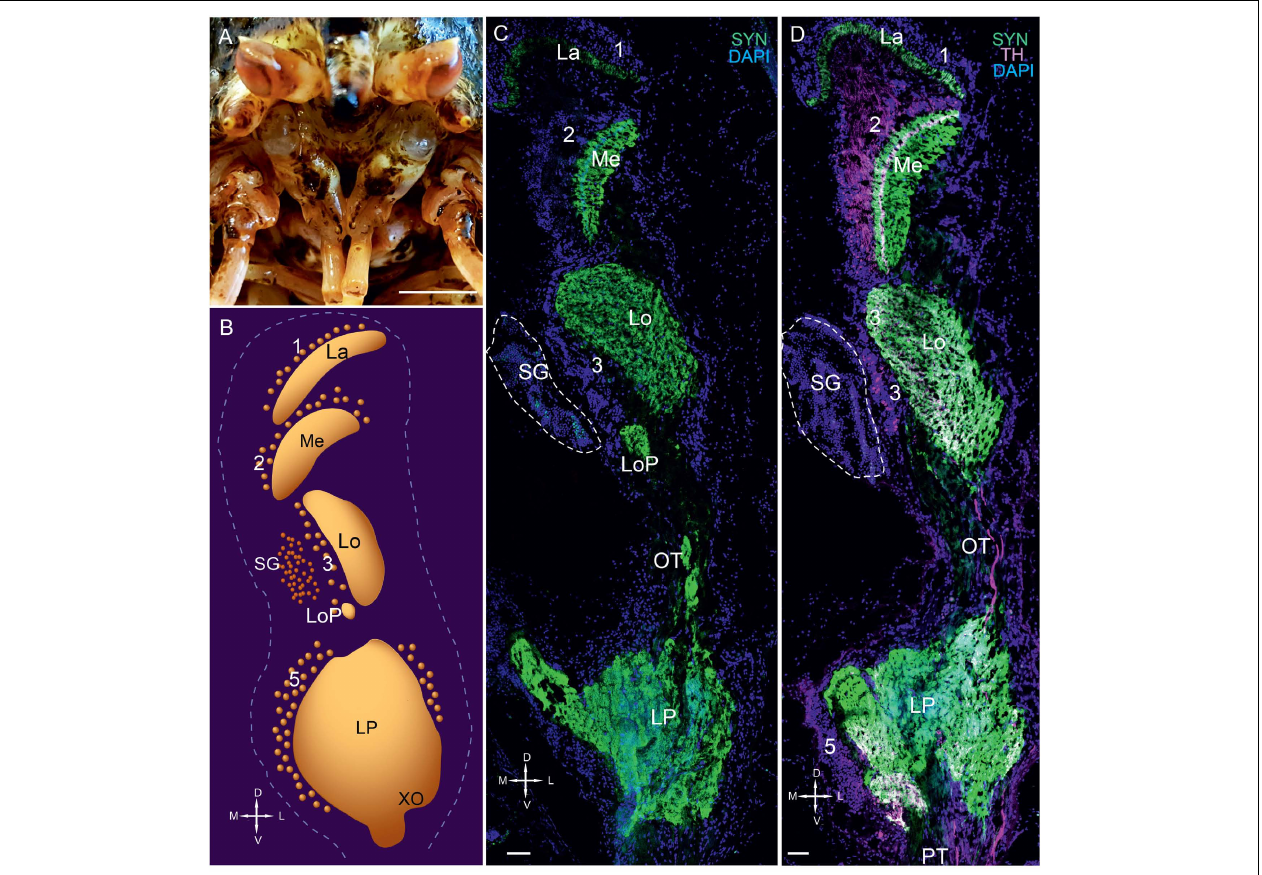
FIGURE 1 | Eyestalks of the red king crab Paralithodes camtschaticus . (A) Photographs demonstrating the position of the eyestalks in P. camtschaticus . (B) Diagram of the optic neuropils, SG, and LP (dorsal view). (C) SYN detected in the optic neuropils and LP of the dorsal to ventral sections. (D) SYN and TH detected in optic neuropils, LP, and OT. Green, SYN; magenta, TH. Dashed lines in panels (C,D) indicate cells corresponding to the SG. Scale bars = (A) 1 cm and (C) 100 µ m. La, lamina; Me, medulla; Lo, lobula; LoP, lobula plate; 1, 2, 3, 5, cell clusters; OT, optic tract; LP, lateral protocerebrum; SYN, synapsin; D, dorsal; V, ventral; L, lateral; M, medial; A, anterior; P,